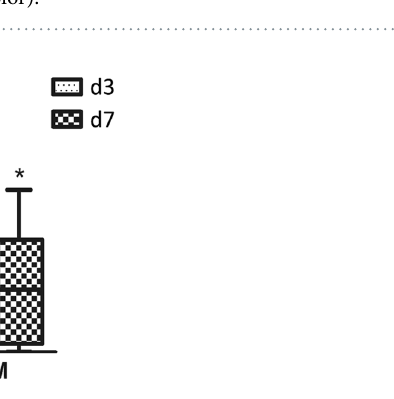
Figure 1. Venn diagrams of the distribution of Operational Taxonomic Units (OTUs) among three study groups on day 3 (d3) and day 7 (d7). The number in the intersection represent the number of OTUs shared among different groups while the number out of the intersection represents the number of unique OTUs in each group. AF, antibiotic free group (red color); PT, piperacillin-tazobactam group (green color); PM, combination of penicillin and moxalactam group (blue color).